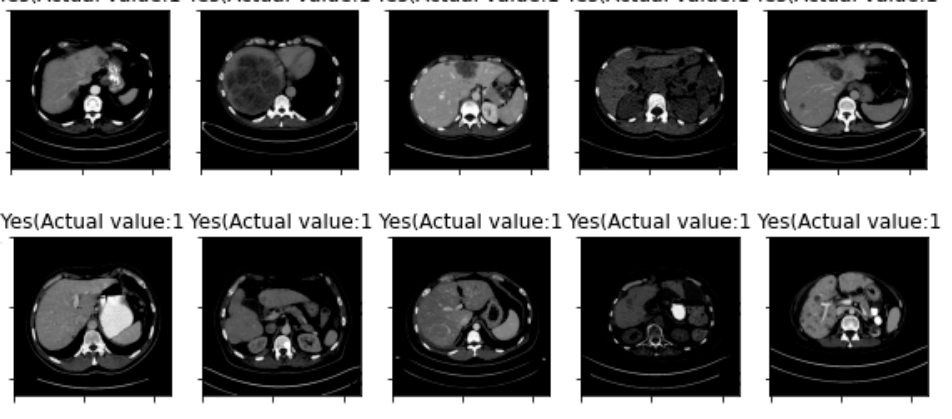
Figure 7. Examples of classification of CT images containing lung tumors.